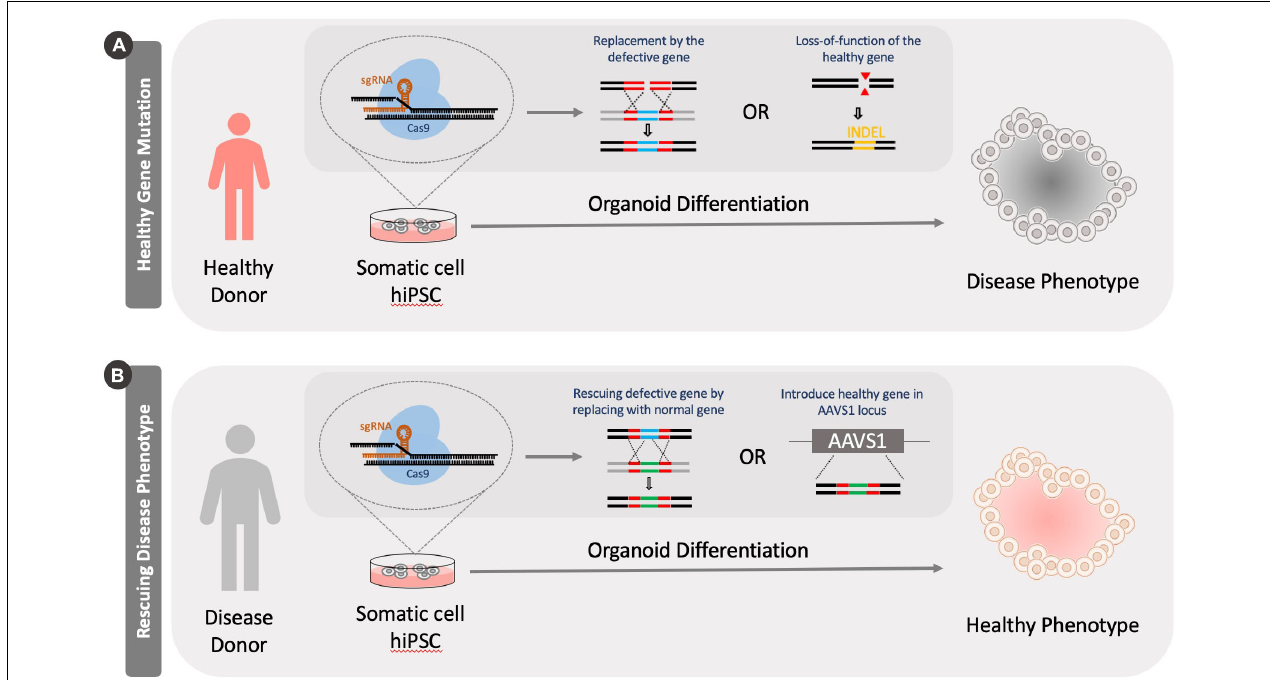
FIGURE 3 | Generation of disease models using CRISPR Cas9 knockout tools. Models can be generated by either knocking out a healthy version of a gene in cells or by rescuing a defective gene. (A) A healthy person’s somatic cells are reprogrammed into a pluripotent stage. Specific disease causing mutations can be introduced to genes in these cells by either knocking in a defective genes or introducing INDELS through genome editing. (B) Alternatively, a diseased patient’s cells can be isolated and reprogrammed into a pluripotent stage. These cells can be then fixed by correcting the mutation by knocking in a functional version of the gene or introducing healthy version at the adeno-associated virus integration site